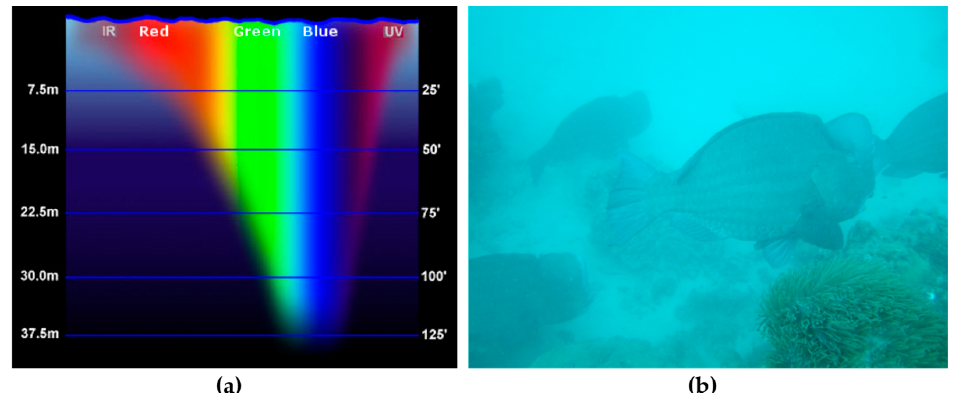
Figure 1. The effects of absorption and scattering. ( a ) Illustration of how light is attenuated through ocean water, with certain wavelengths penetrating deeper than others. At depths of 30 m, light from the red, orange, yellow and ultraviolet parts of the spectrum is completely attenuated. ( b ) Hazy underwater image. Distant objects viewed underwater are often low in contrast and blurred due to the process of scattering.